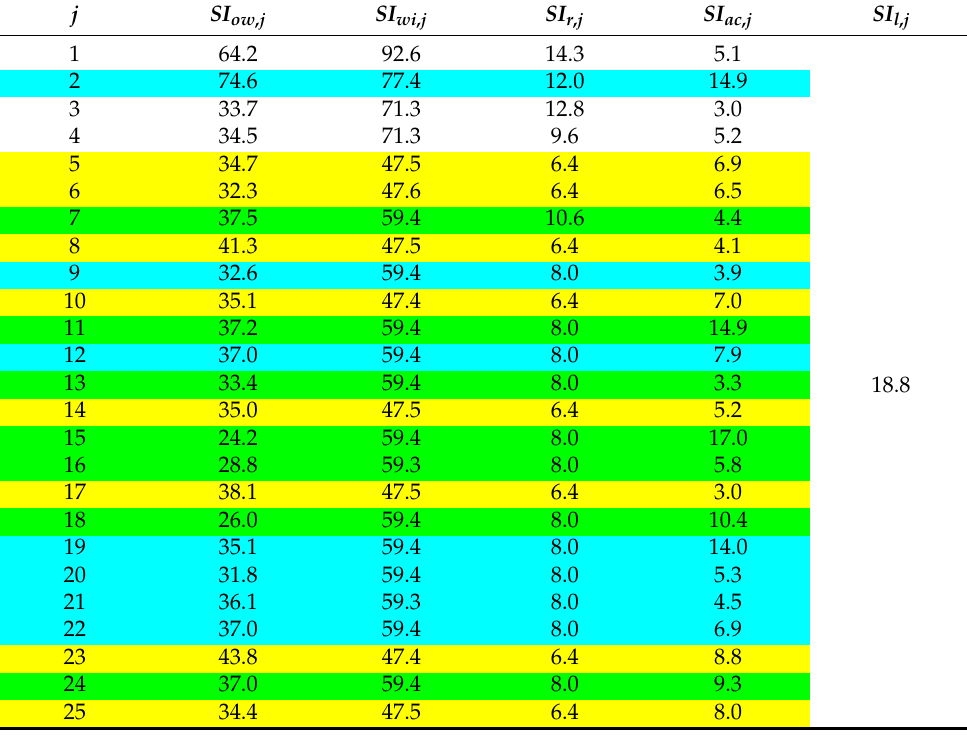
Table 4. Relative economic performance recalculation for individual energy saving measures. SI = spe- floor building, green—two-story building, light blue—three-story building, white—four- or five-story building. j SI ow ,